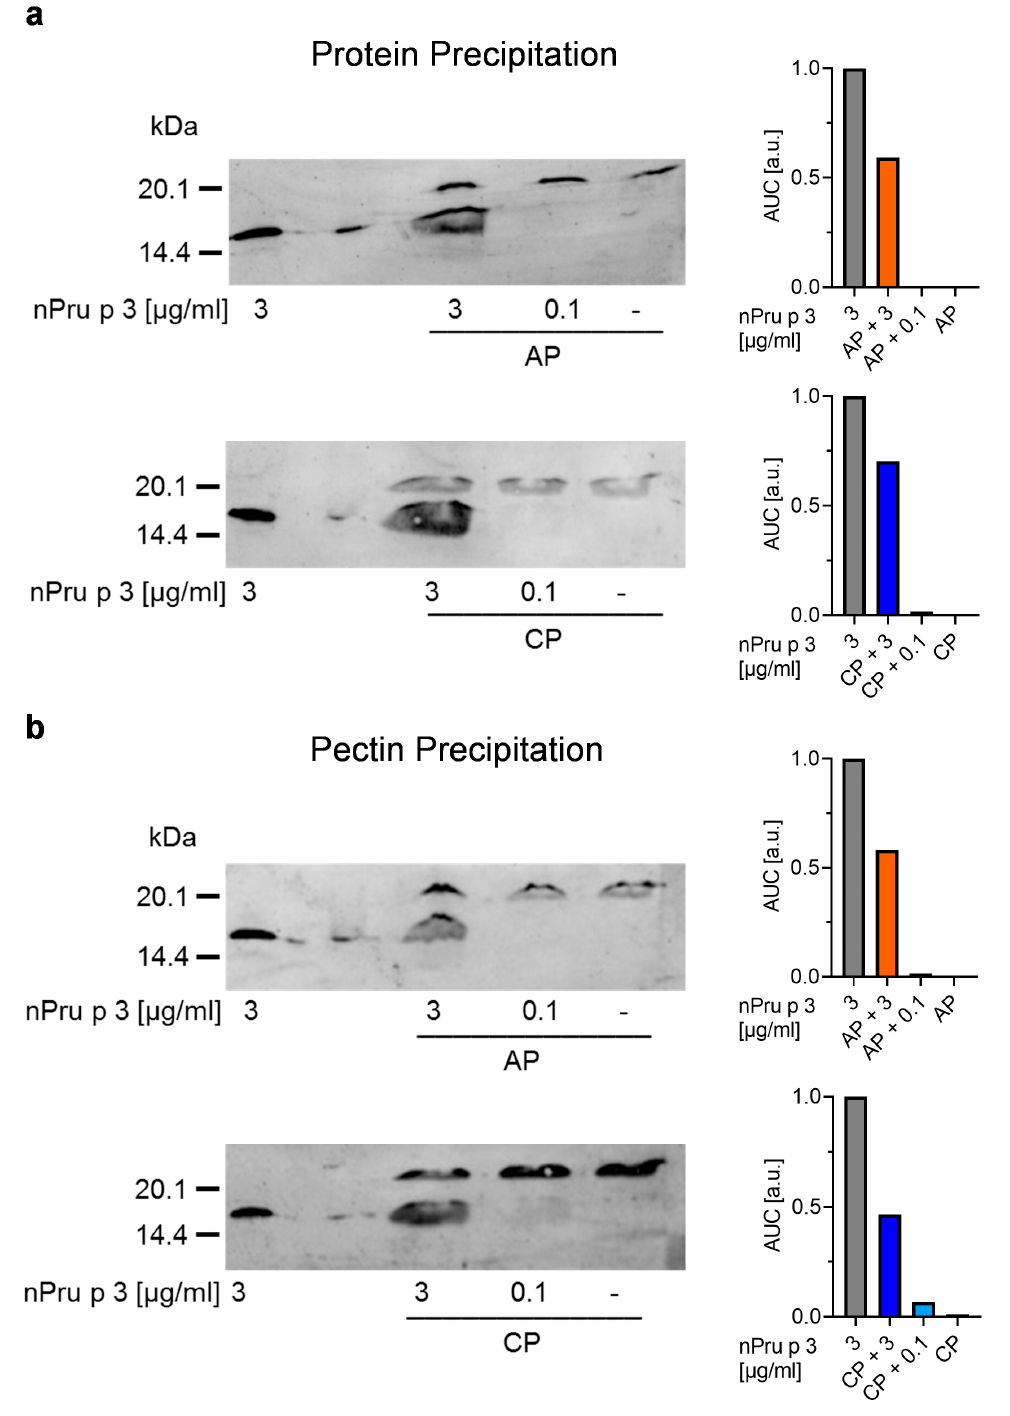
Figure 6. Precipitation of protein ( a ) or pectin ( b ) and subsequent analysis via immunoblotting. nPru p 3 concentrations representing the anaphylactic (3 µg/mL) or oral allergy syndrome (OAS) threshold (0.1 µg/mL) spiked in 10% Fruktozym-treated pectins, unspiked pectins and purified nPru p 3 were used for precipitation. The protein detectability was semi-quantified using the area under the curve (AUC) normalized to blank. 3 µg/mL (suggested threshold for anaphylactic reactions) or 0.1 µg/mL (suggested thresh- old for OAS) of nPru p 3, purified nPru p 3, as well as unspiked pectin. Subsequently, the